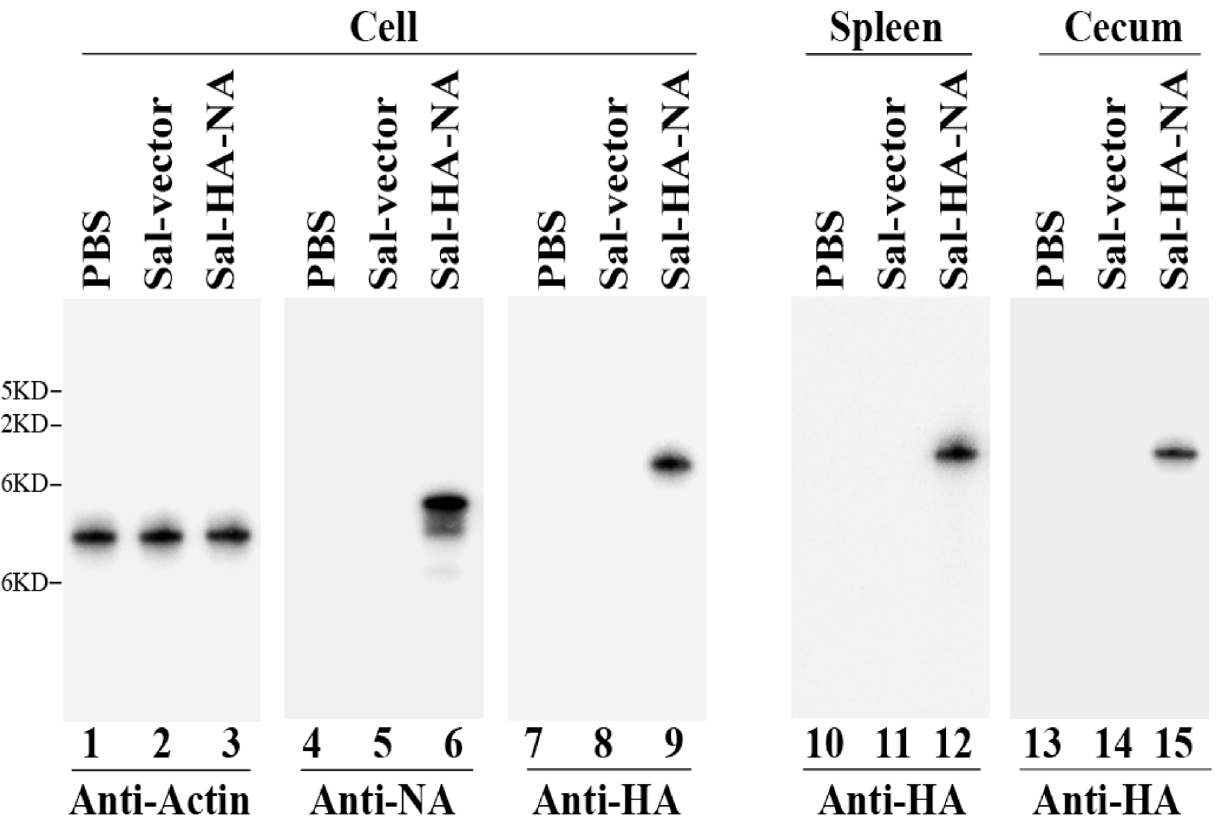
Fig 2. Salmonella -mediated delivery for influenza antigen expression in cells and in mice. Western blot analyses were performed to study the expression of viral HA and NA proteins in differentiated THP-1 cells (lanes 1 – 9) and viral HA protein in BALB/C mice (lanes 10 – 15) treated with phosphate- buffered saline (PBS) only (PBS, lanes 1, 4, 7, 10, and 13), SL368 carrying the empty vector construct pVAX1 (Sal-vector, lane 2, 5, 8, 11, and 14) and constructs p5HA and p5NA (Sal-HA-NA, lanes 3, 6, 9, 12, and 15). Cells treated with PBS or Salmonella were harvested at 72 hours post treatment while spleens and cecums were harvested from BALB/C mice that were intragastrically inoculated with PBS or SL368 carrying different constructs at 4 days after inoculation. Protein samples (40 μ g) were separated on denaturing gels, transferred to membranes, and stained with antibodies against viral HA (lanes 7 – 15) and NA (lanes 4 – 6) or actin (lanes 1 – 3), which serves as the loading control. Molecular markers are shown on the